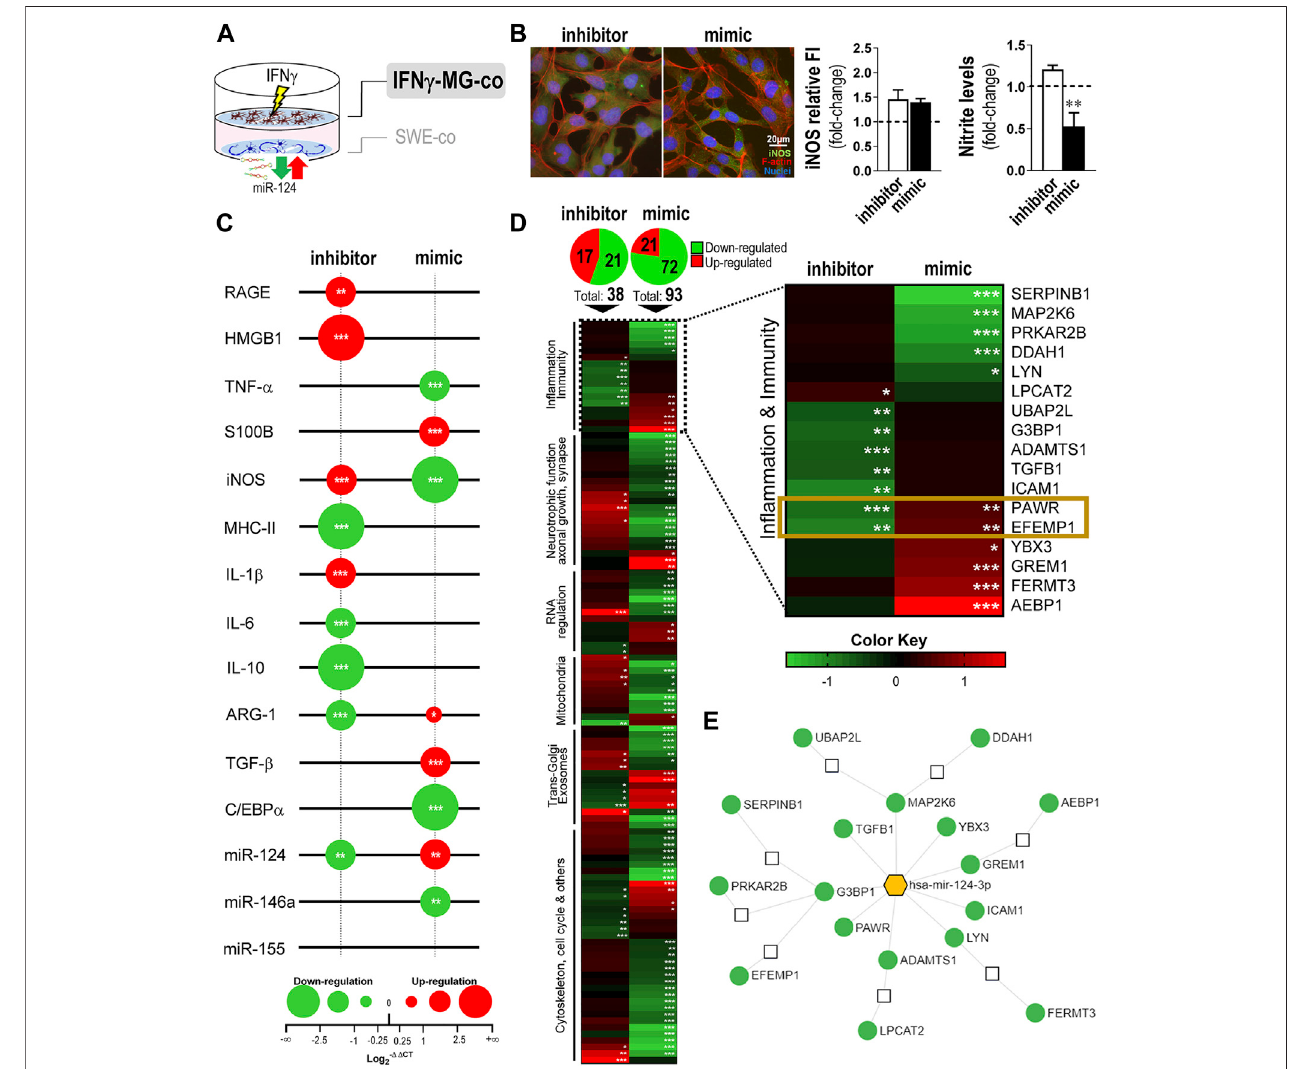
FIGURE 5 | Modulation of miR-124 expression levels in SWE cells changes the reactive and proteomic pro fi le in human IFN γ -MG upon established cocultures. After differentiation, SWE cells were transfected with miR124 inhibitor and mimic, while CHME3 microglia were pre-treated with IFN γ for 24 h (IFN γ -MG) before the coculture, as detailed in Materials and Methods . (A) Schematic representation of the SWE/IFN γ -MG coculture and subsequent indication on microglia effects. (B) Representative fl uorescence intensity (FI) of iNOS (green) and f-actin (red) in IFN γ -MG cells with quanti fi cations of iNOS relative to FI and nitrite accumulation in cell media, right. Nuclei were stained with Hoechst 33258 dye (blue). (C) Bubbleplot showing thechangesin in fl ammatory-associated gene/miRNA expression ofIFN γ -MG after coculture with inhibitor- and mimic-treated SWE cells. The color of the bubbles indicates downregulated genes (green) or upregulated genes (red), and the size represents the magnitude of each down/upregulation. (D) Heatmap representation of 117 proteins identi fi ed and quanti fi ed by mass spectrometry-based proteomic analysis of IFN γ -MG cells cocultured with SWE (inhibitor vs . mimic). A subset of 17 proteins related to innate function and in fl ammation was highlighted based on their Gene Ontology (GO) classi fi cation. Colors indicate downregulated proteins (green) or upregulated proteins (red), and the intensity of each color represents the relative abundanceoftheindicatedprotein.Signi fi cantproteomicdataaredetailedin SupplementaryTableS2 . (E) TargetingnetworkofmiR-124foreachofthe17highlighted proteins, created in the “ miRnet.ca ” platform. Results are mean ± SD from at least three independent experiments. * p < 0.05, ** p < 0.01, and *** p < 0.001 vs . IFN γ -MG cocultured with SWE mock control, one-way ANOVA with the Bonferroni post hoc test. SWE, human SH-SY5Y expressing the APP695 Swedish mutant protein; MG, CHME3 human microglia cells; IFN γ -MG, IFN γ -stimulated CHME3 human microglia cells; co, cocultured; miR, miRNA; f-actin, fi lamentous-actin; iNOS, inducible nitric oxide synthase; RAGE, receptor for advanced glycation end products; HMGB1, high mobility group box protein 1; TNF- α , tumor necrosis factor α ; S100B, S100 calcium-binding protein B; iNOS, inducible nitric oxide synthase; MHC-II, major histocompatibility complex – class II; IL, interleukin; ARG-1, arginase-1; TGF- β , transforming growth factor β ; C/EBP α , CCAAT enhancer binding protein α